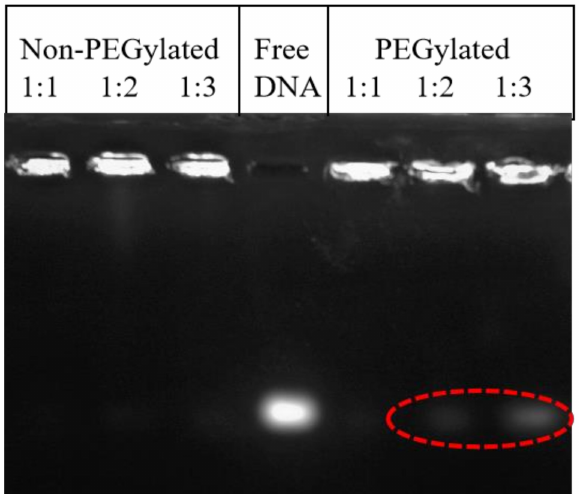
Figure 2. Agarose gel electrophoresis of nonPEGylated 1:1, 1:2 and 1:3 DC-chol/DOPE liposomes, free DNA, and PEGylated 1:1, 1:2 and 1:3 DC-chol/DOPE lipoplexes (from left to